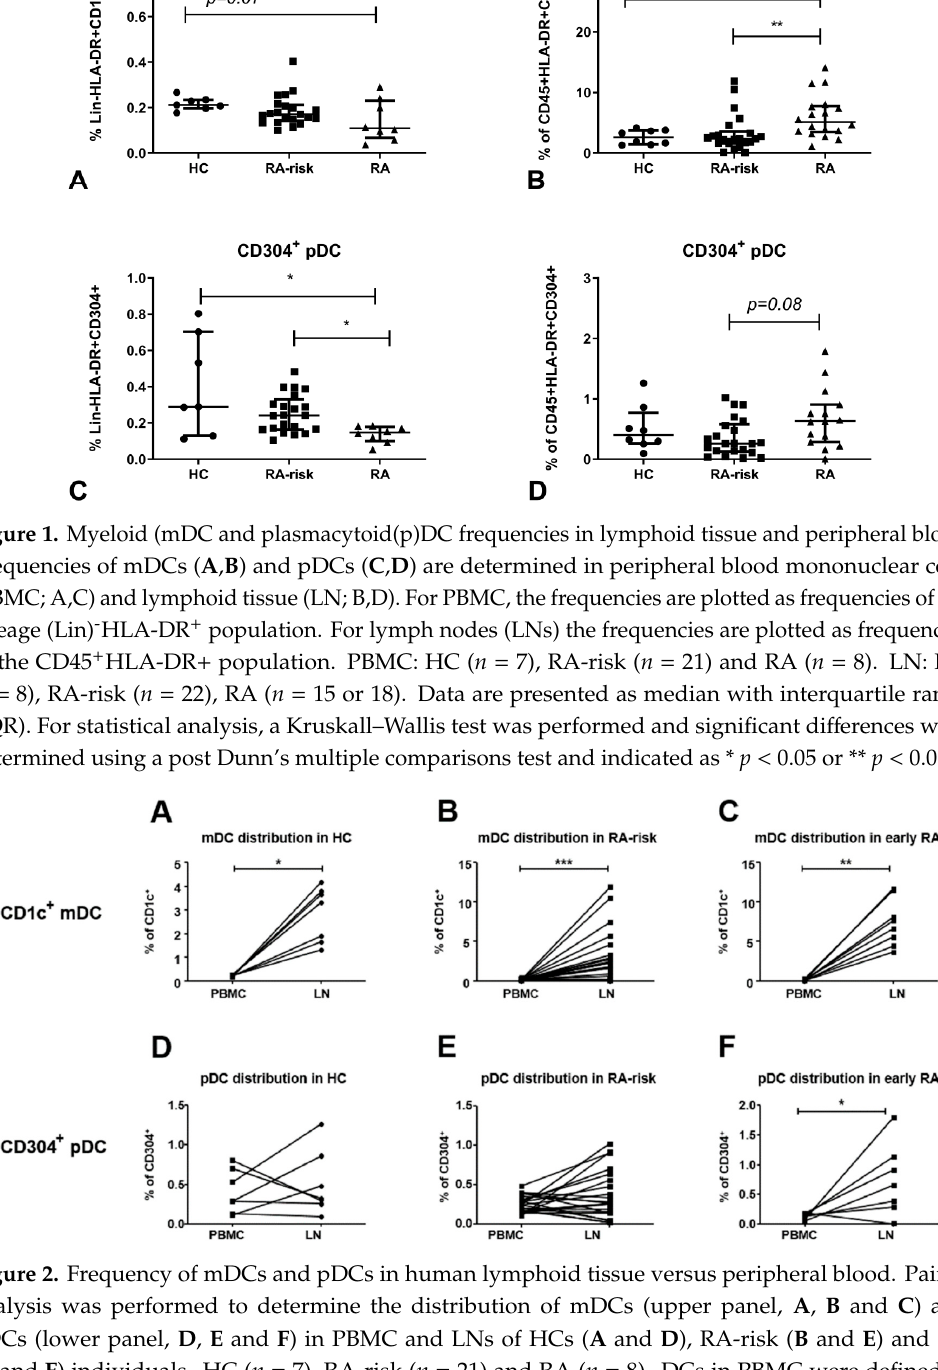
Figure 2. Frequency of mDCs and pDCs in human lymphoid tissue versus peripheral blood. Paired analysis was performed to determine the distribution of mDCs (upper panel, A , B and C ) and pDCs (lower panel, D , E and F ) in PBMC and LNs of HCs ( A and D ), RA-risk ( B and E ) and RA ( C and F ) individuals. HC ( n = 7), RA-risk ( n = 21) and RA ( n = 8). DCs in PBMC were defined as Lineage - HLA-DR + CD1c + or CD304 + , while DCs in LN tissue were defined as CD45 + HLA-DR + CD1c + or CD304 + . For statistical analysis, paired data were analyzed with a Wilcoxon matched pairs test (* p < 0.05 or ** p < 0.01, *** p < 0.001 ).